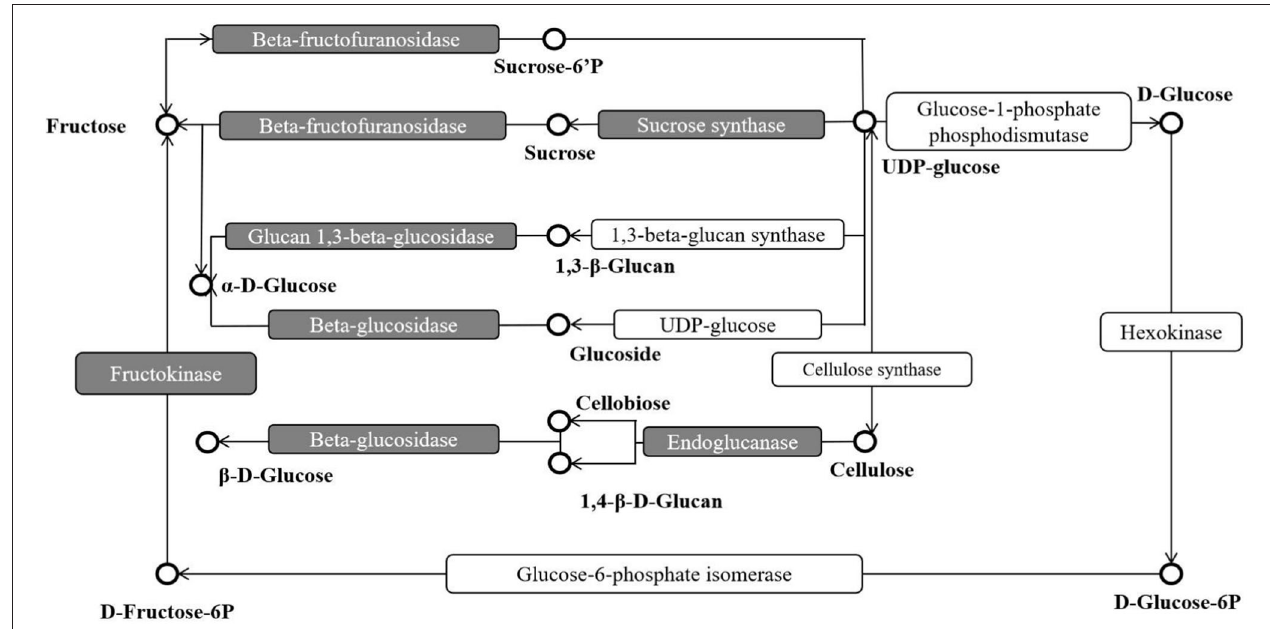
FIGURE 4 | The DEG-enriched points in the KEGG pathway “Starch and Sucrose metabolism”. The sucrose synthase, fructokinase, and beta-fructofuranosidase in red were DEG-enriched points and they might eventually affect sucrose.